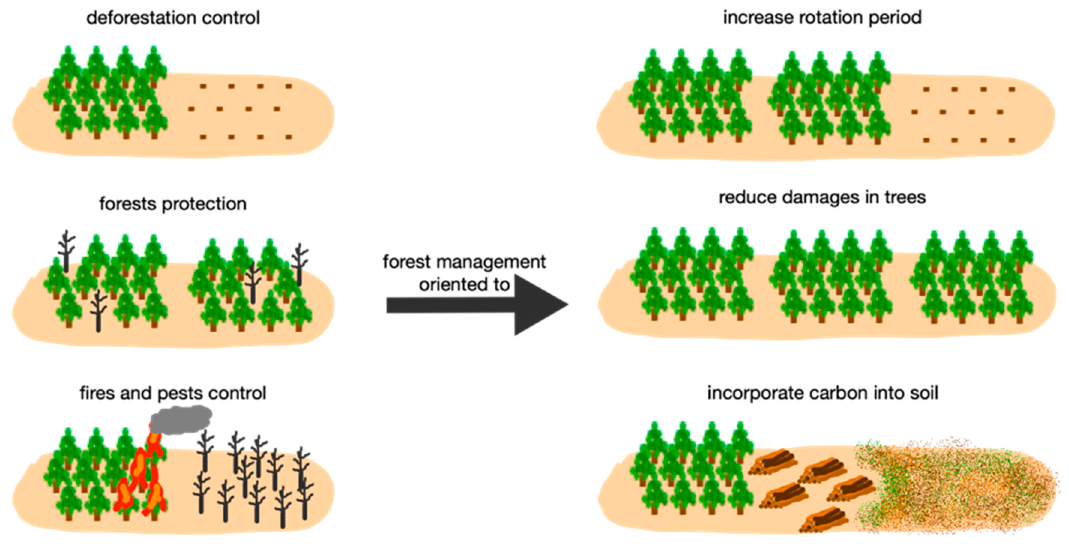
Figure 4. Forest management model for carbon conservation (adapted from [136] ).